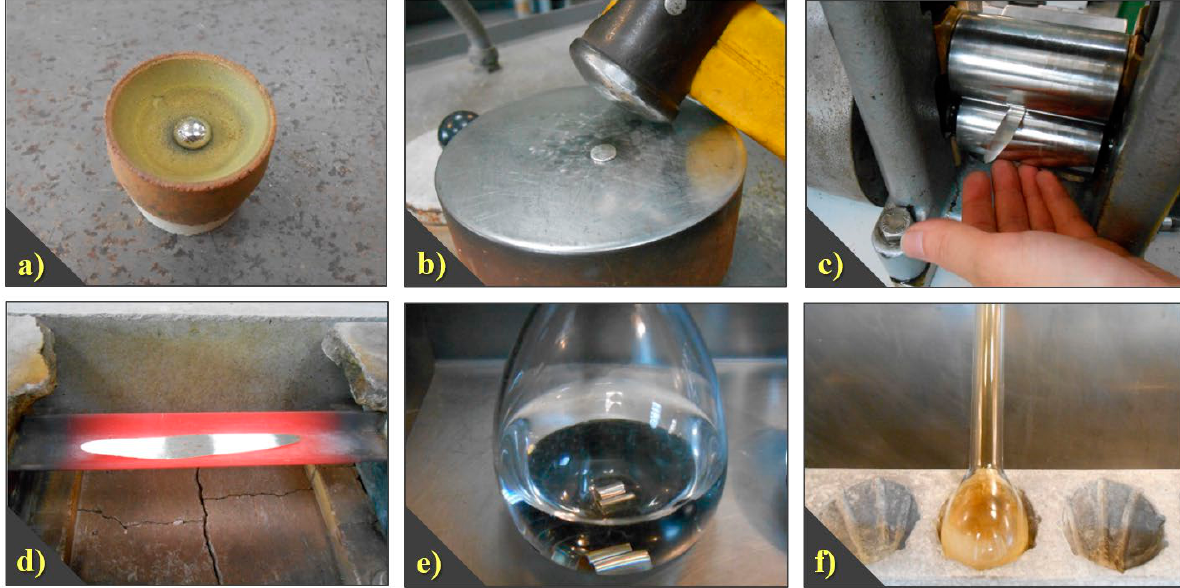
Figure 1. Characteristic gold parting steps on a laboratory scale. After the inquartation stage (a), the precious metal bead is hammered (b), rolled (c) and annealed (d). The parting process occurs inside a Kjeldahl flask (e), keeping the rolled specimen in a boiling acid solution (f).